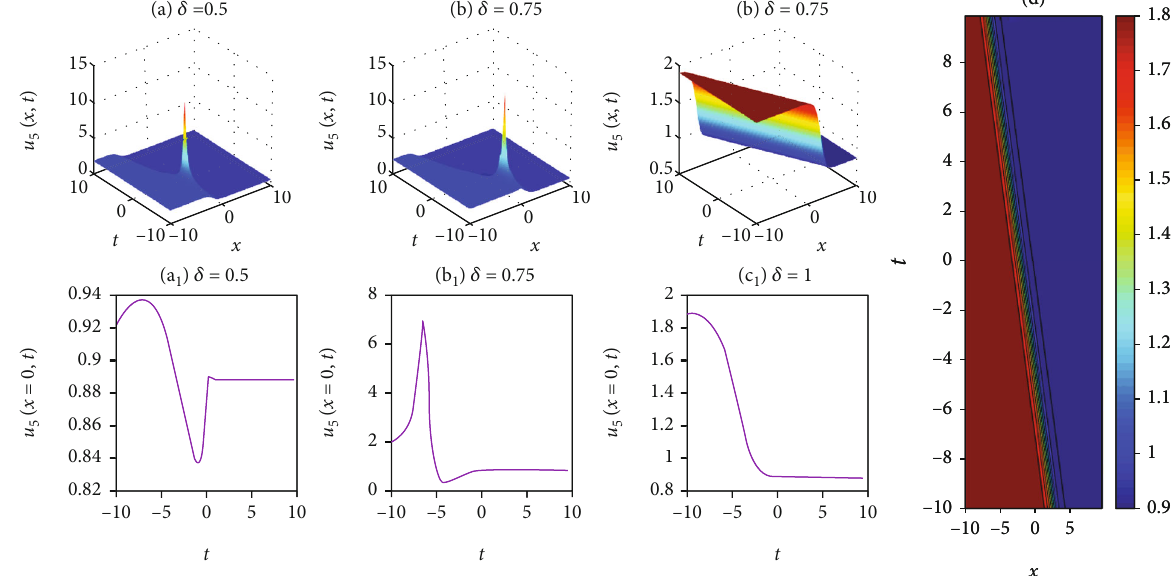
ð x , t Þ . (a – c) 3D plots. (a 5